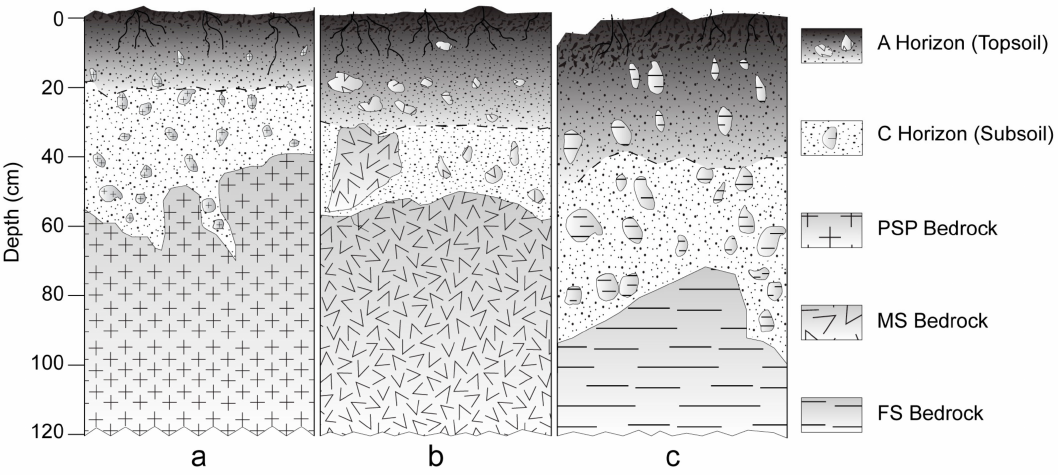
Figure 3. Schematic sketch of soil profiles developed on: ( a ) PSP; ( b ) MS; ( c ) FS. The dashed black lines represent the contact between A and C